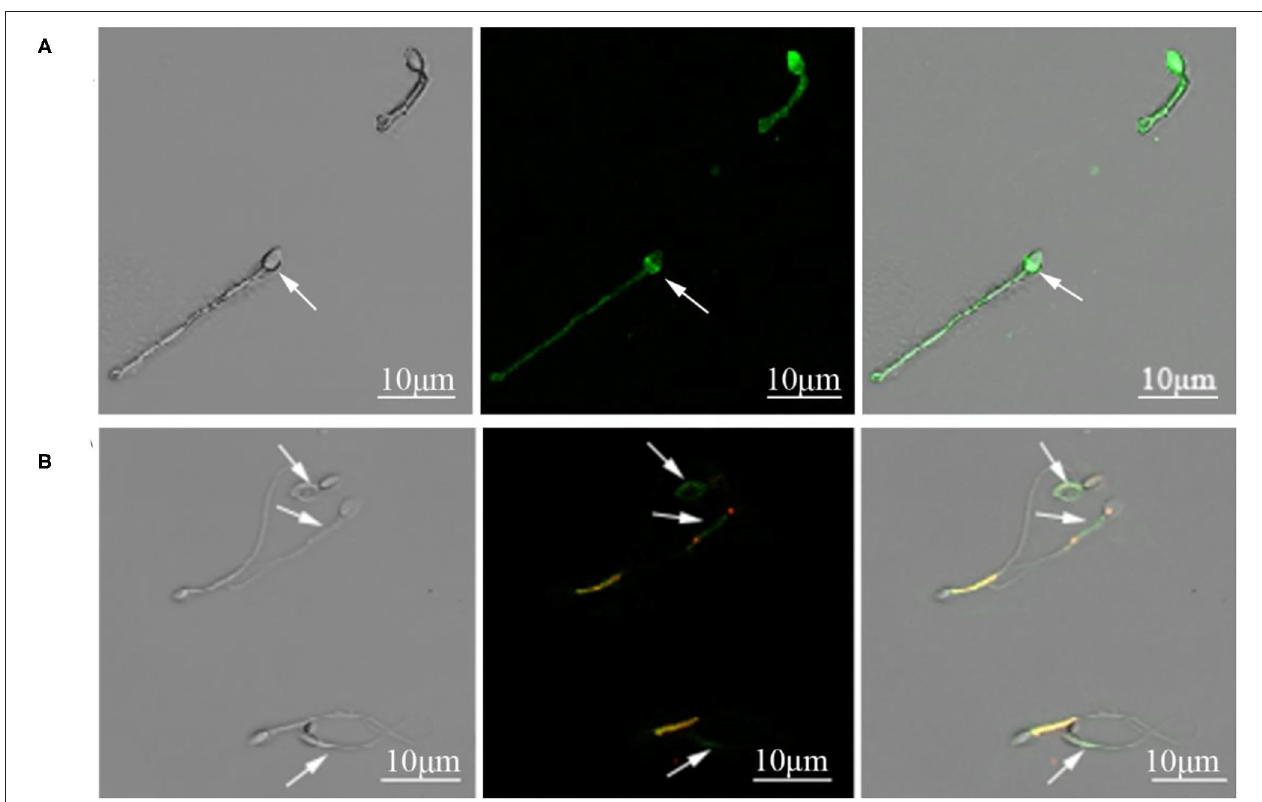
FIGURE 1 | (A) Cynomolgus macaque sperm with intact and damaged acrosomes. The arrow indicated a sperm with damaged acrosome. (B) Sperm with intact and damaged mitochondria function. The arrows indicated sperm with compromised mitochondrial membrane potential.